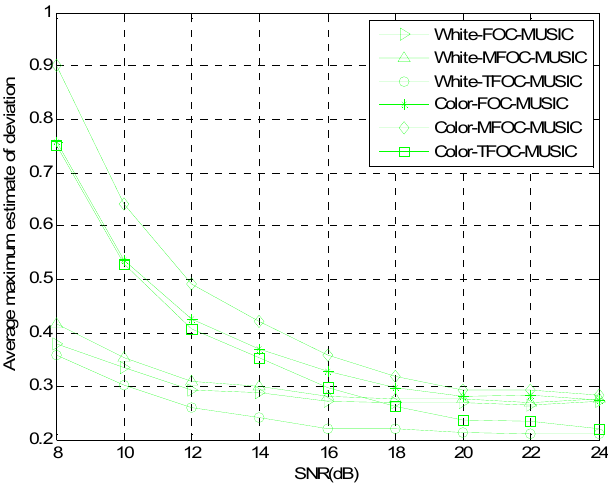
Figure 3. Average maximum estimate deviation comparisons versus SNR.